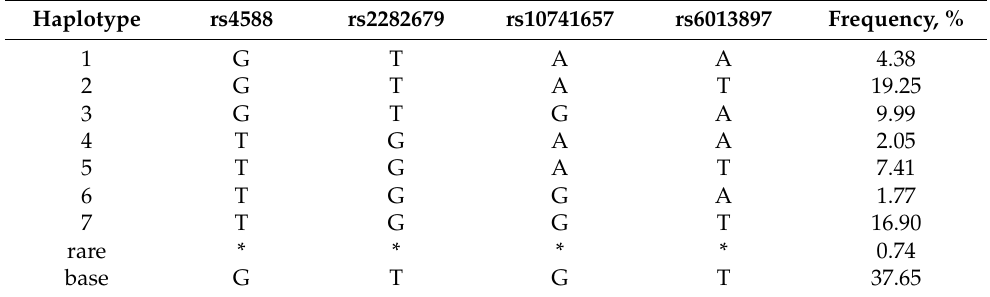
Table 5. Haplotypes combination.